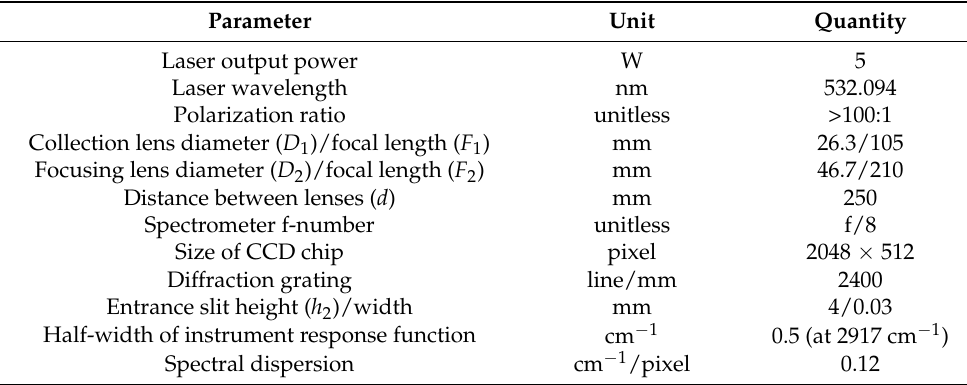
Figure 1. Schematic of the experimental setup. Table 1. Characteristics of the experimental setup.